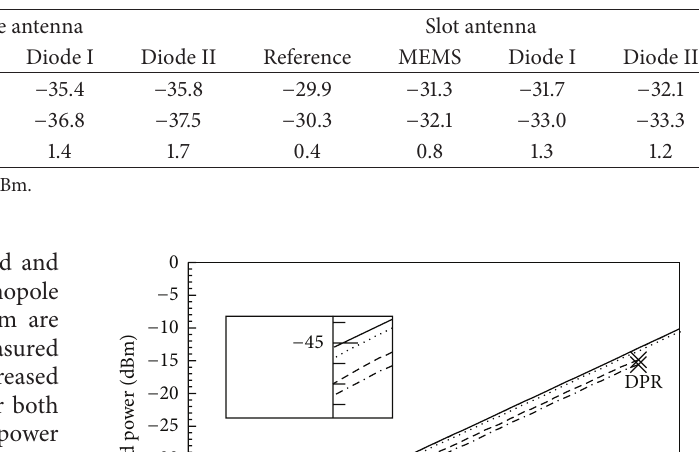
Table 2: Comparison of the calculated and the measured receiving power.